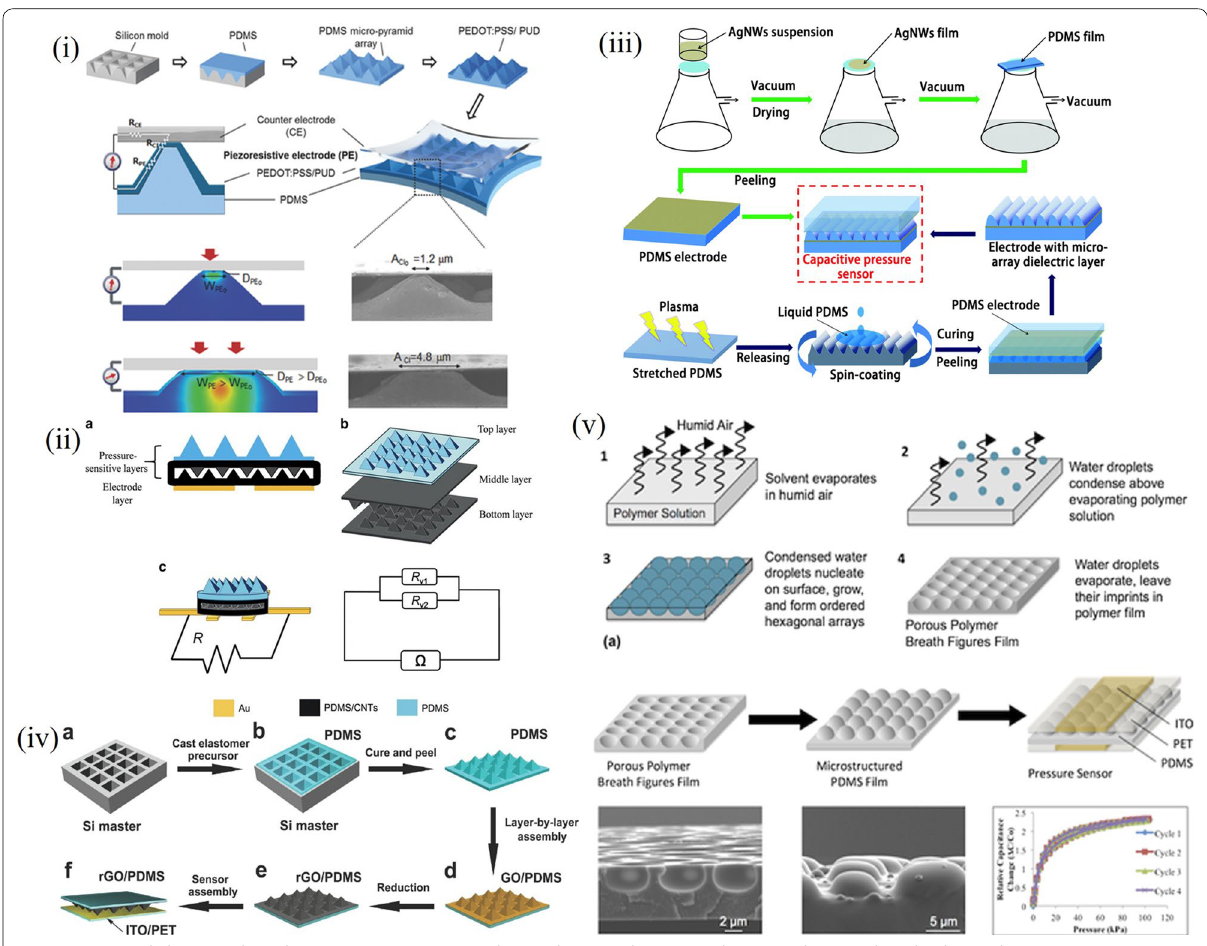
Fig. 4 Patterned elastomer based strain/pressure sensor with varied approaches (i) Conducting polymer induced enhanced conductivity(Reproduced by permission from [49] Copyright 2014, Wiley ) (ii) rGO/PDMS patterned (Reproduced by permission from [58] Copyright 2016, Springer ) (iii) Plasma induced electrode defined on wrinkled PDMS (Reproduced by permission from [50] Copyright 2018, Royal Society of Chemistry ) (iv) Compound elastomer pattern with complimentary rGO/PDMS films (Reproduced by permission from [47] Copyright 2014, Wiley ) (v) Patterned PDMS with breath figures (Reproduced by permission from [51] Copyright 2014, IOP science